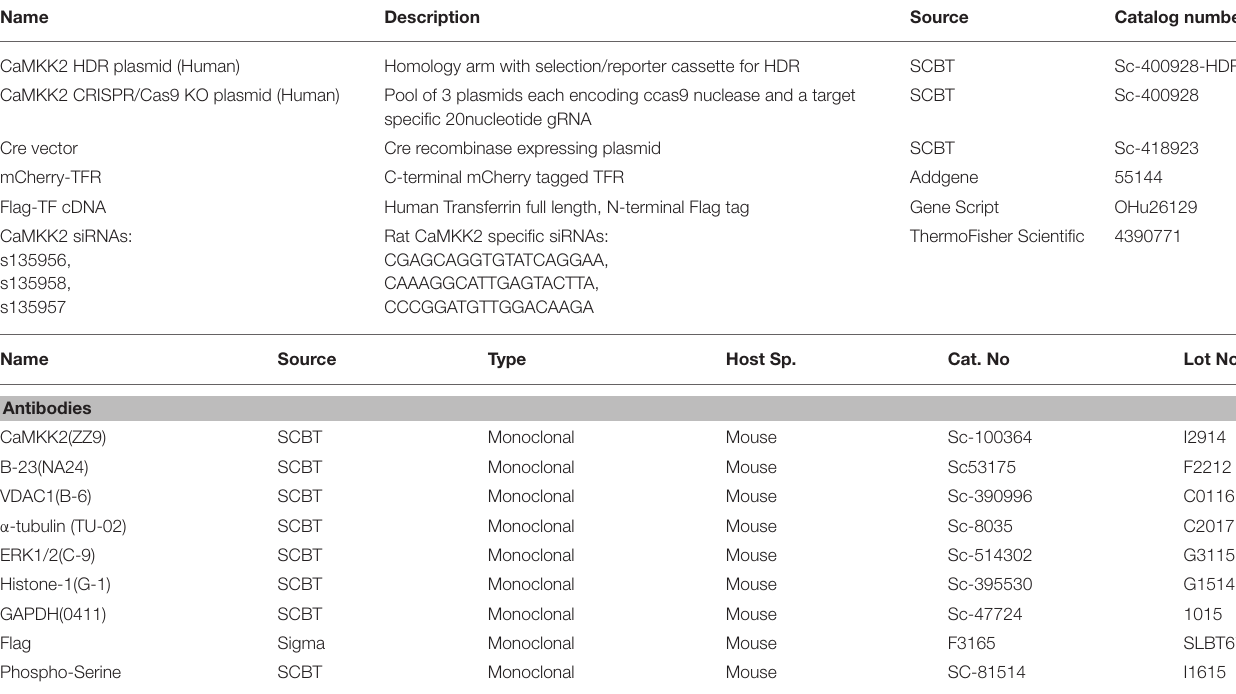
TABLE 1 | List of Antibodies and other